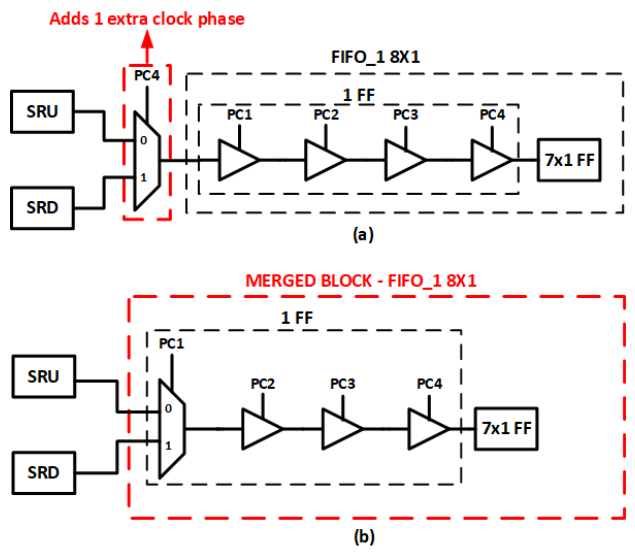
Figure 4. Example of a merged block in the round function: ( a ) multiplexer and FIFO _1 8 × 1 before merging, ( b ) multiplexer and FIFO _1 8 × 1 after